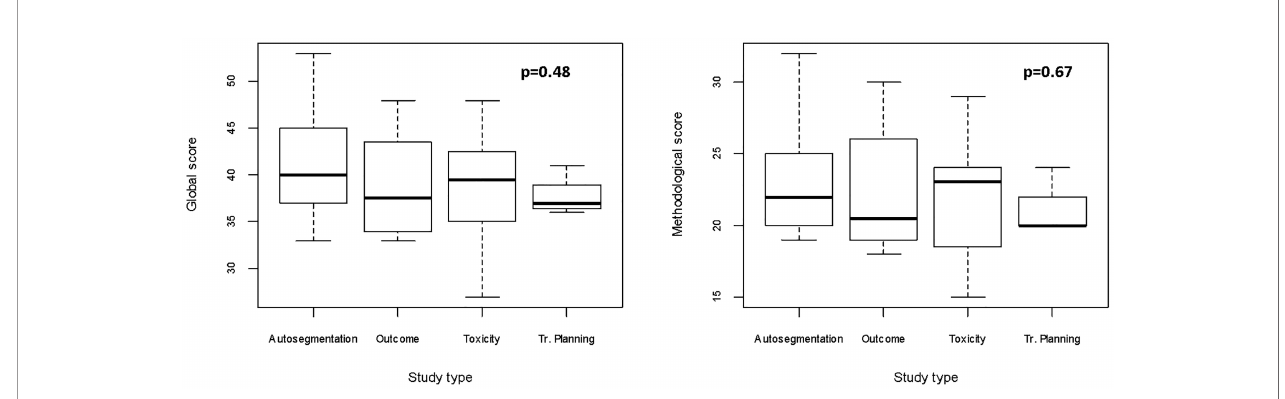
FIGURE 4 | Boxplots for global and methodological scores (modi fi ed Luo classi fi cation) for the studies included in the analysis, categorized according to the task of the proposed algorithm(s).